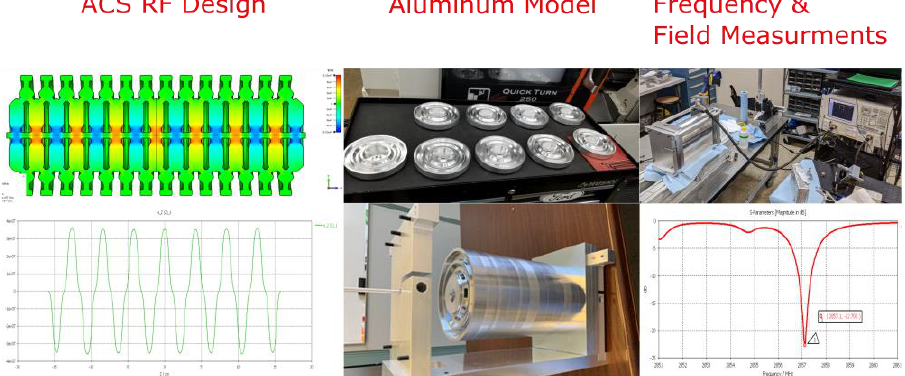
Figure 5. Design, cold model, and measurements of the annular-coupled structure (ACS) developed by Argonne in collaboration with RadiaBeam.